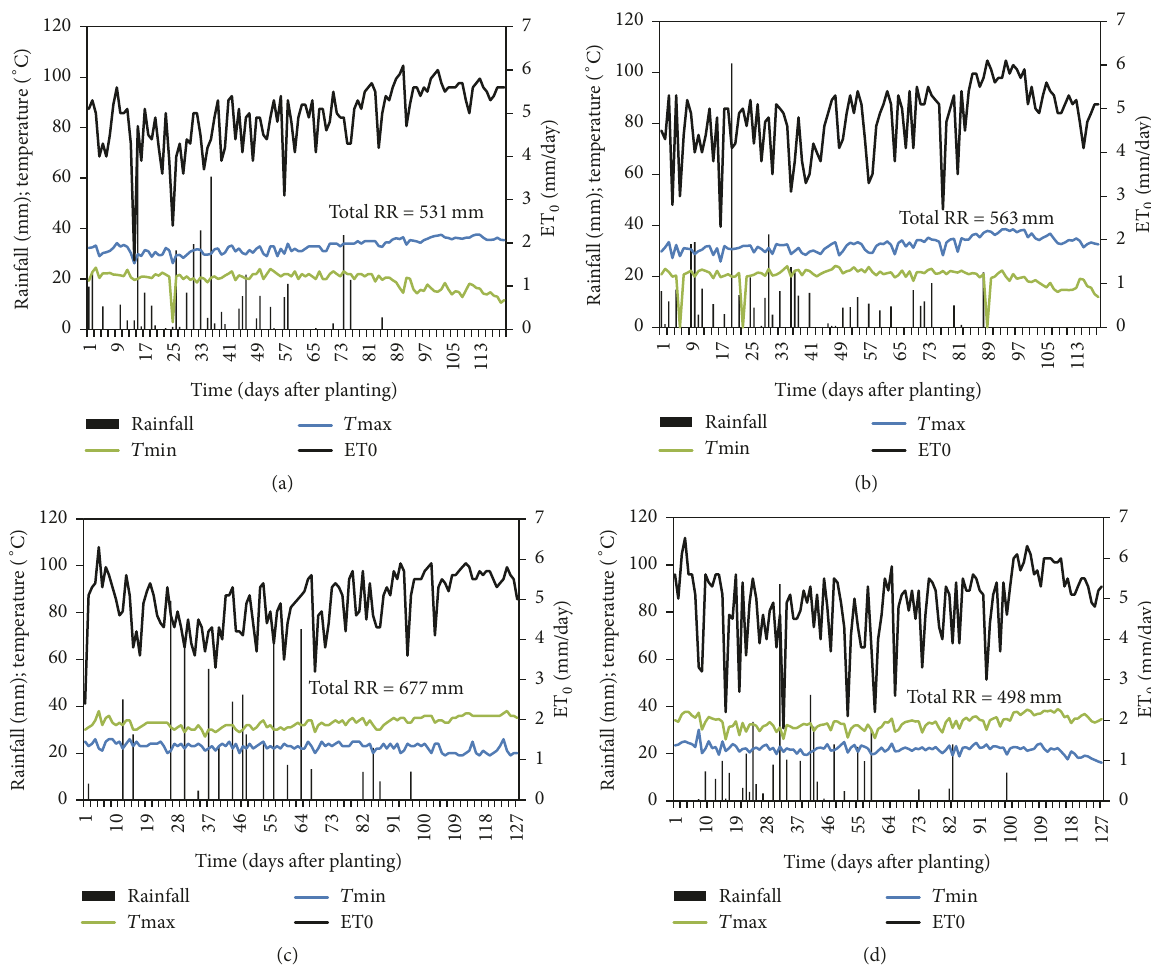
Figure 1: Calculated daily reference evapotranspiration ( ET 0 ) , minimum temperature (𝑇 min ) , maximum temperature (𝑇 max ) , and rainfall during the growing seasons of (a) BUK, 2014; (b) BUK, 2015; (c) Minjibir, 2014; and (d) Minjibir,